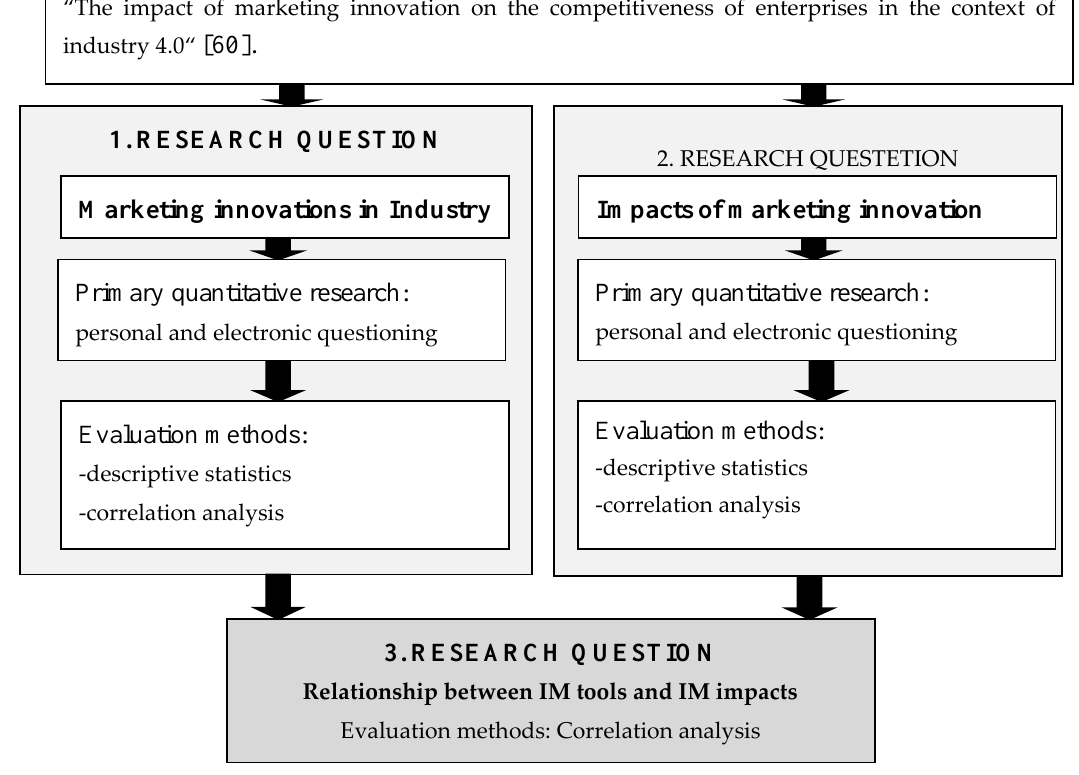
Figure 1. Conceptual framework of this study. Source: own.